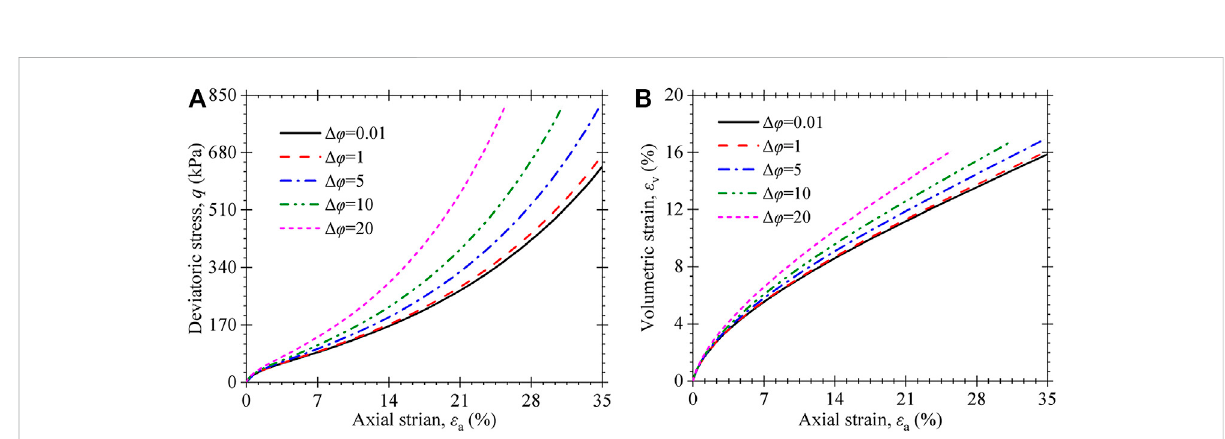
FIGURE 17 In fl uence of Δ φ on the stress – strain behavior of MSW under con fi ning stress of 50kPa; (A) stress – strain curves; (B) volumetric strain vs. axial strain curves.